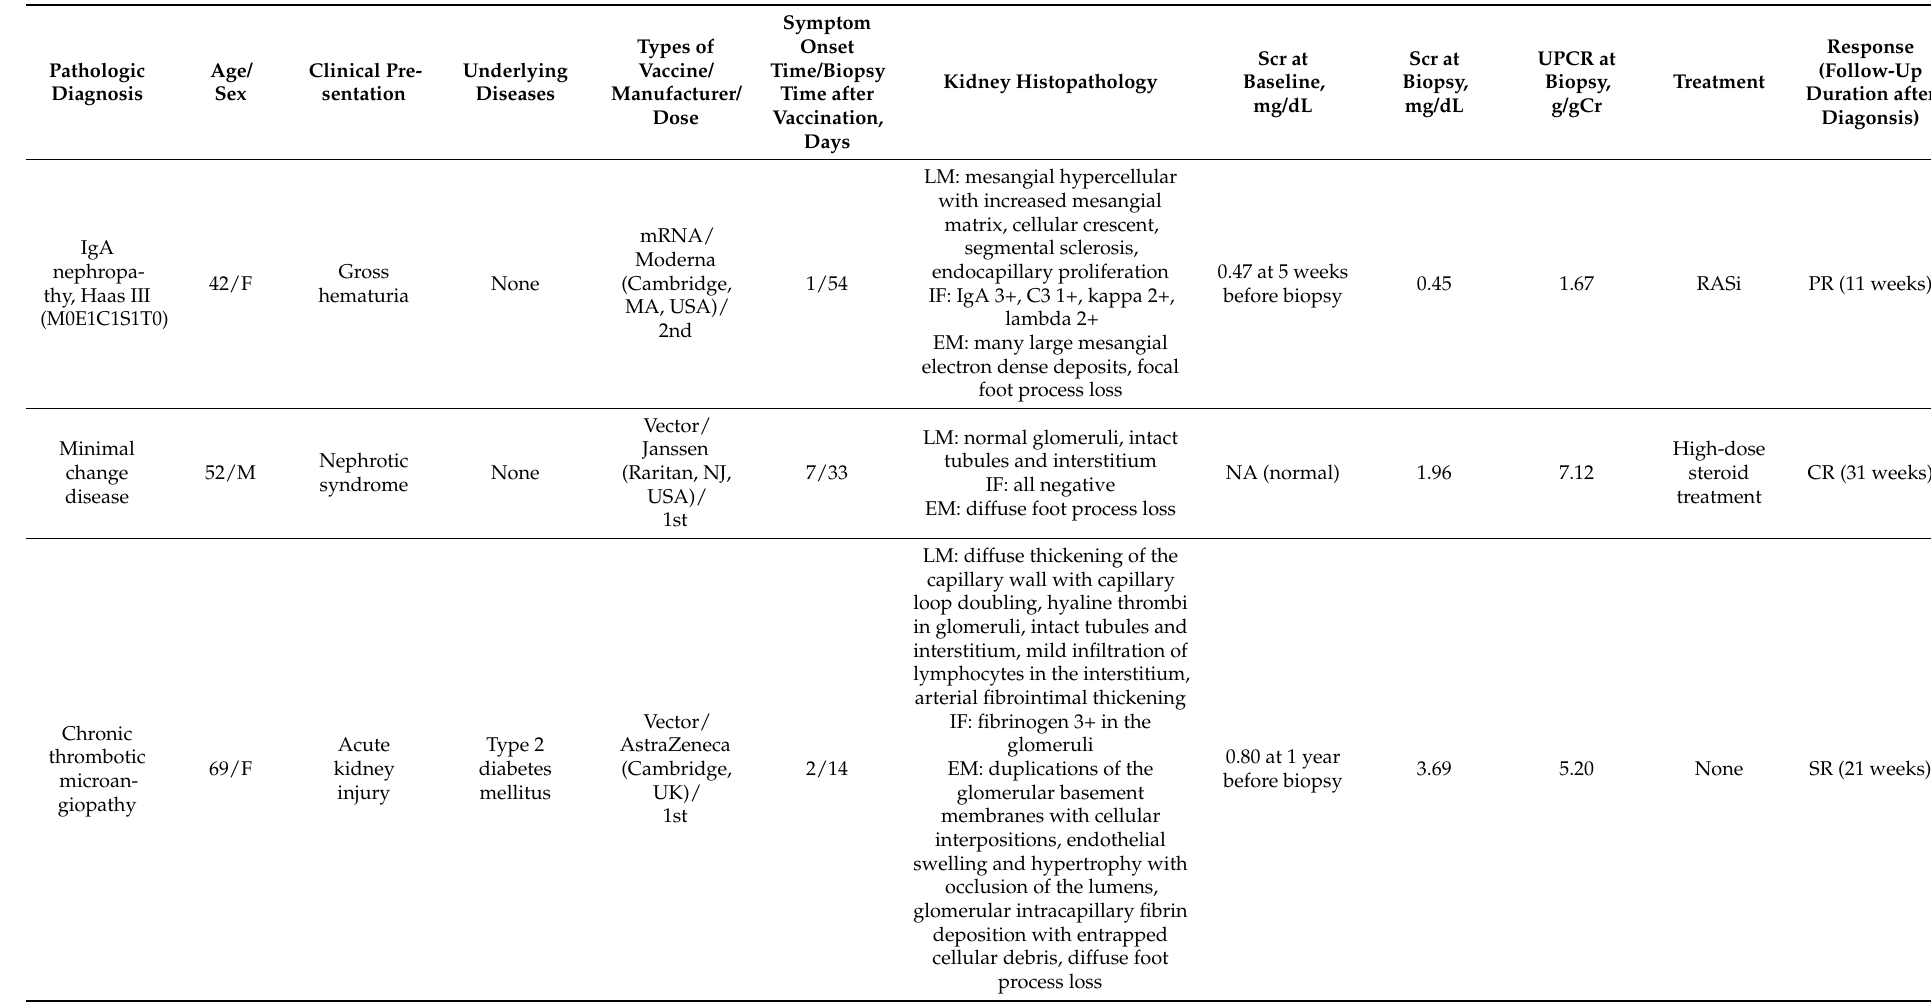
Table 1. Summary of presented cases of new-onset renal